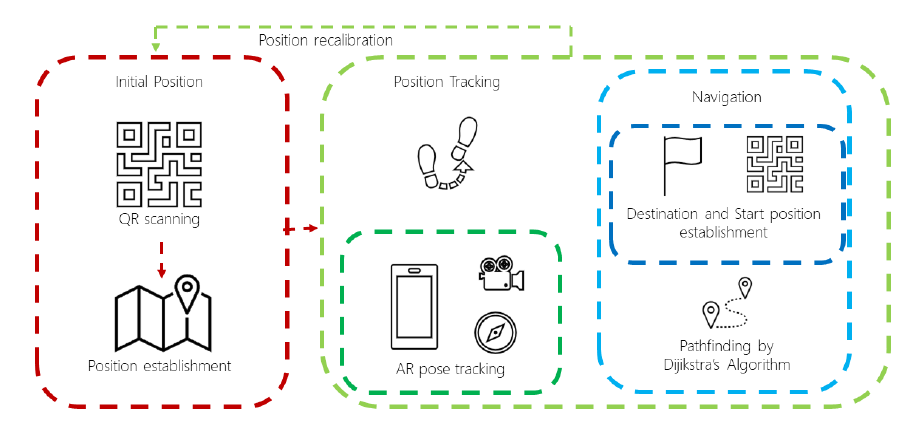
Figure 3. Implementation diagram of the Positioning and Navigation